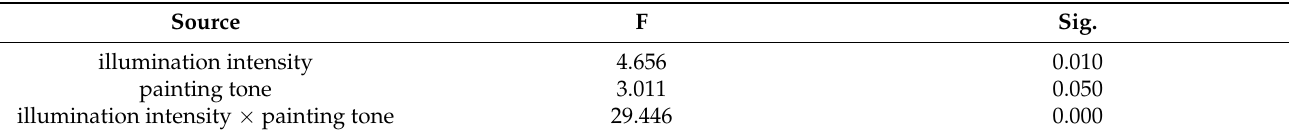
Table 10. Multivariate analysis of variance.